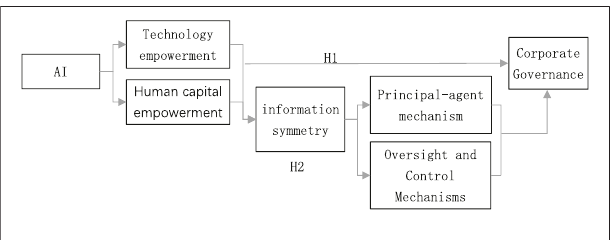
FIGURE 1 | Theoretical conceptual